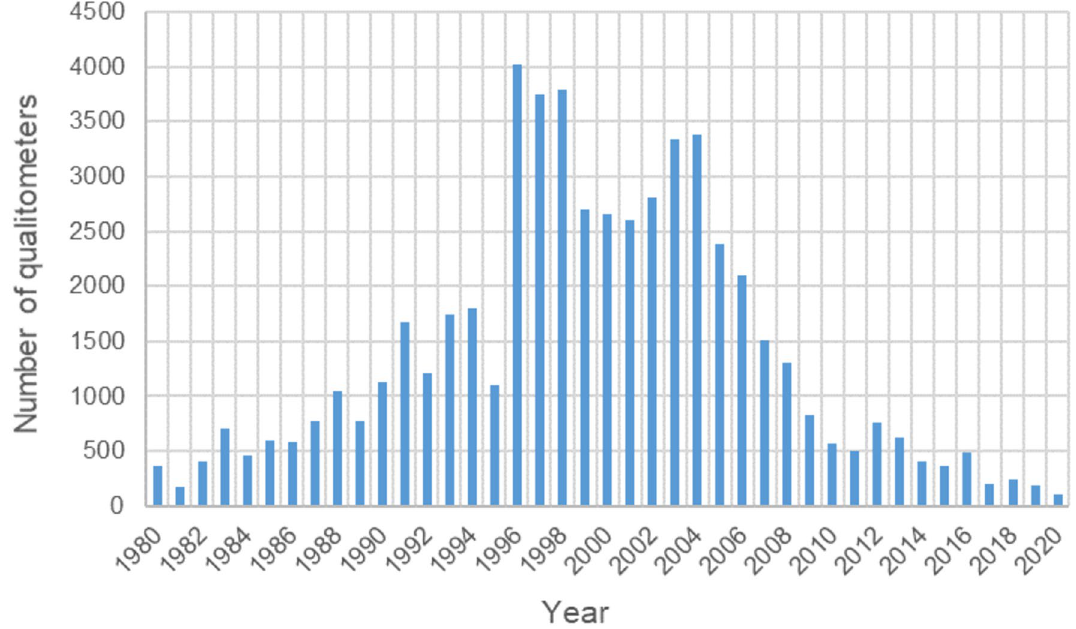
Fig. 3 Number of new “qualitometers” in ADES per year between 1980 and